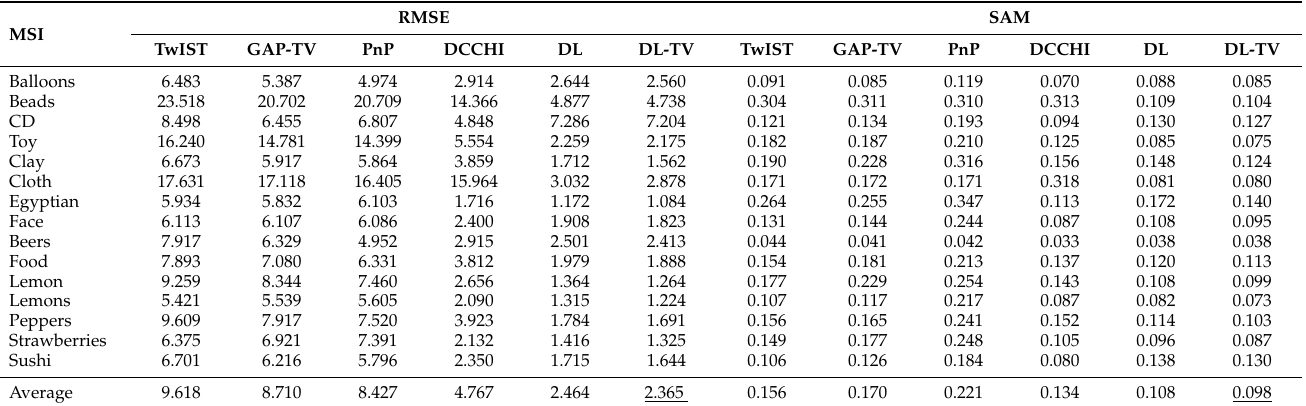
Table 2. Average root-mean-square error (RMSE) and spectral angle mapper (SAM) of the 15 recon- structed MSIs corresponding to the CAVE dataset.